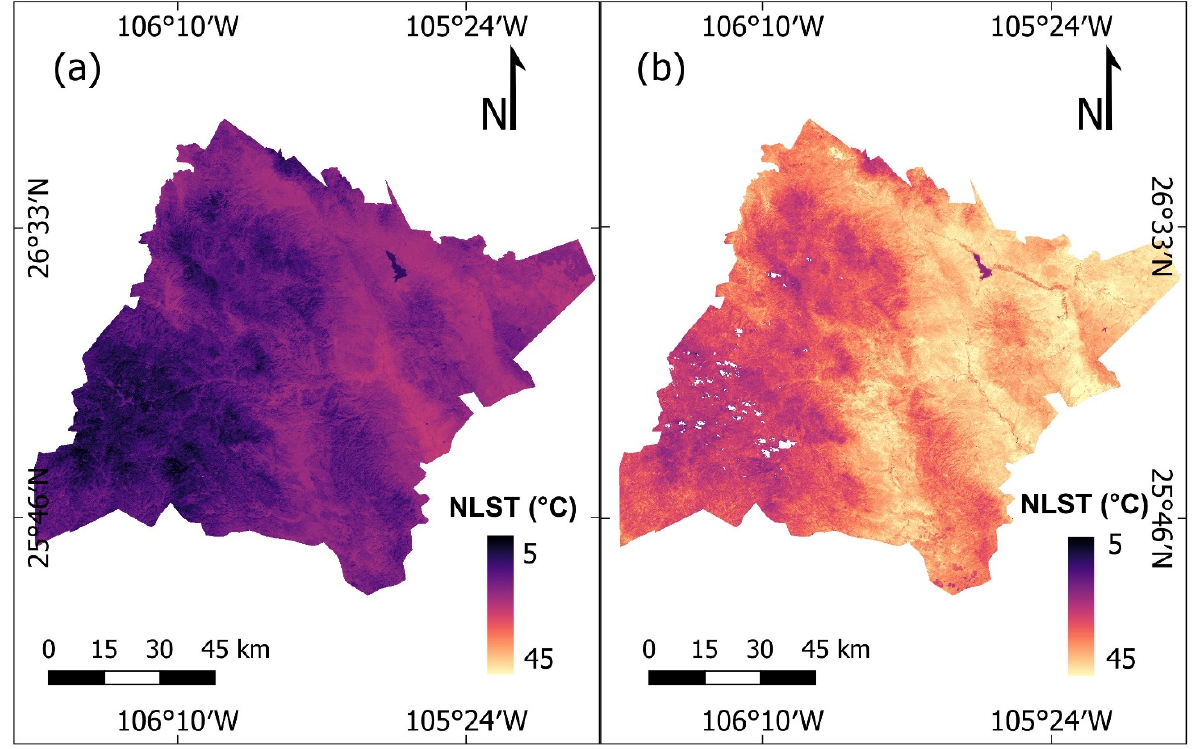
Figure 3. NLST estimated for two seasons of year. ( a ) winter; ( b ) summer.